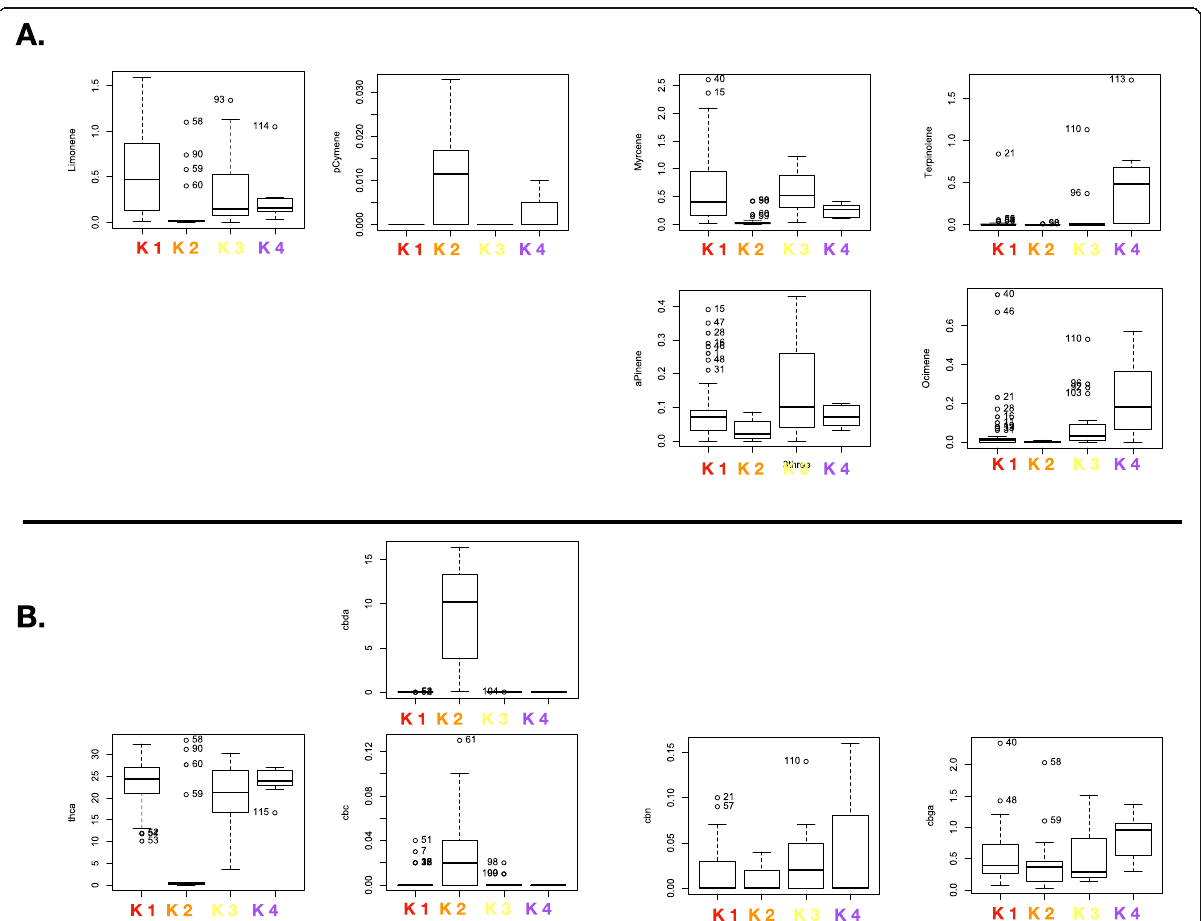
Fig. 4 Boxplots of chemotypic data for each inferred K1- K4. No chemotype data was available for K5, yet all individuals from that cluster are expected to display a low resin type-III phenotype. a Total terpene percentage per dry weight content as determined by GC-MS. b